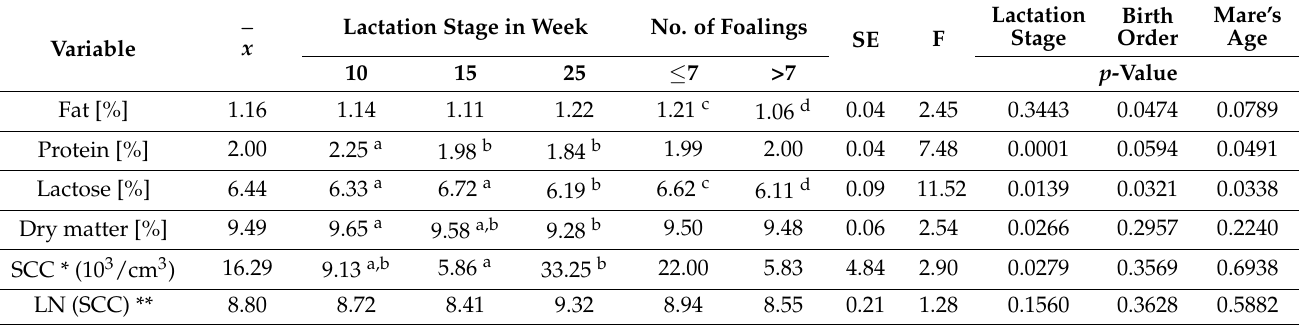
Table 1. Effect of lactation stage, birth order, and mares’ age on chemical composition and somatic cell count of mare’s milk. ¯ Variable